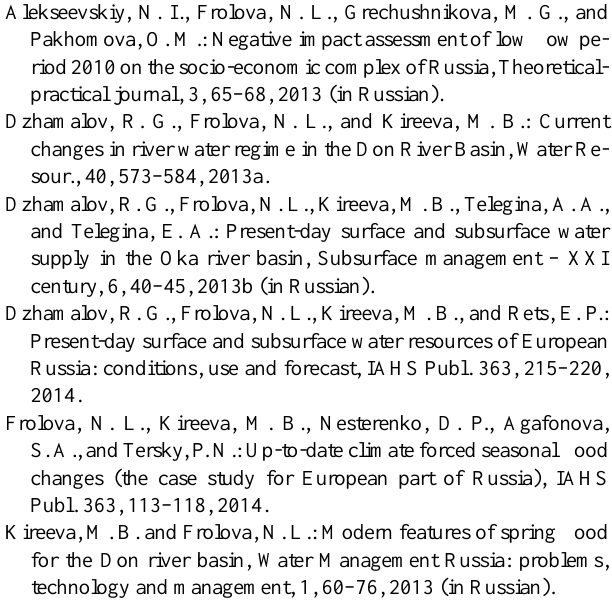
Figure 6. Volume of surplus (a) and deficit (b) for the Volga– Staritsa and volume of surplus (c) and deficit (d) for the N. Dvina–